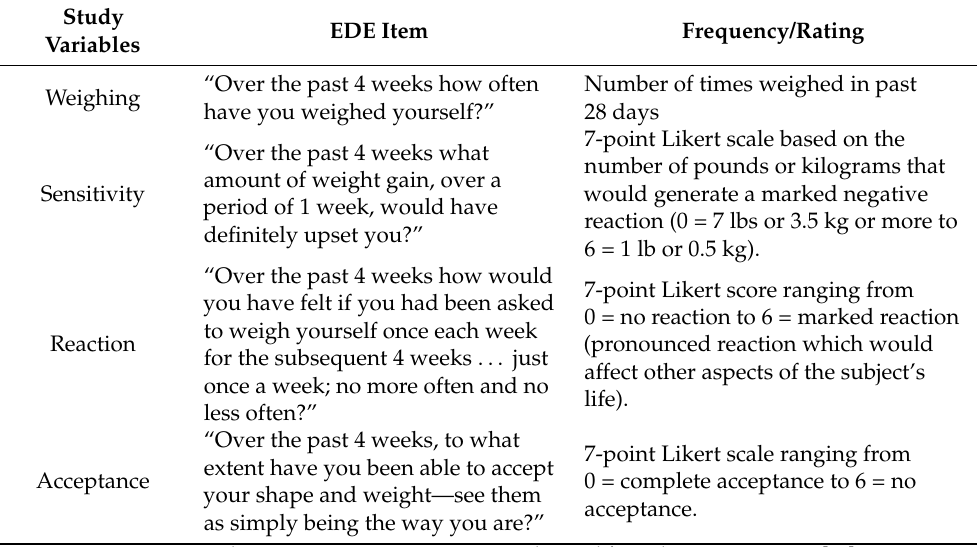
Table 1. Weighing and body image variables prospectively